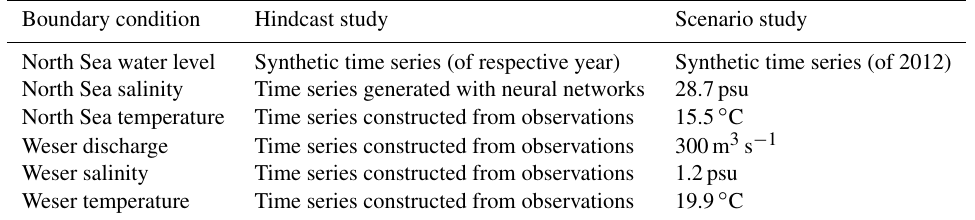
Table 1. Boundary values in hindcast study (realistic forcing) and scenario study (identical forcing). In each study, simulations of system state 1966, 1972, 1981, and 2012 were